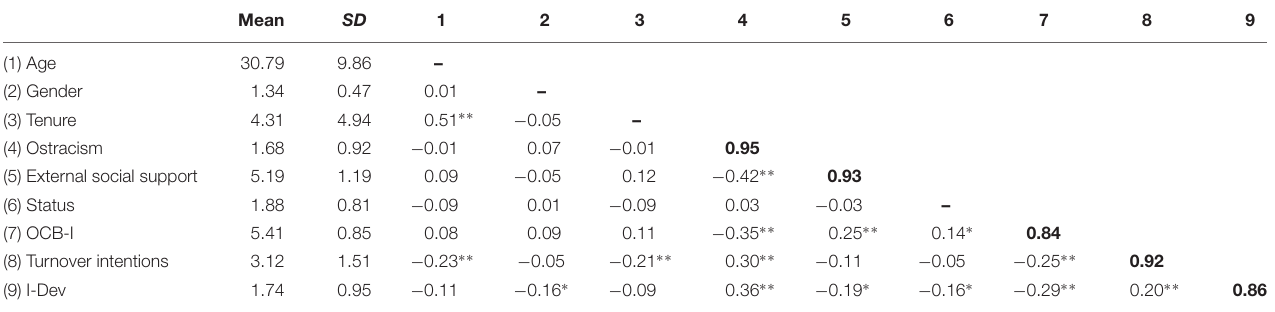
TABLE 4 | Study 2: Descriptive statistics, zero-order correlations, and alphas.